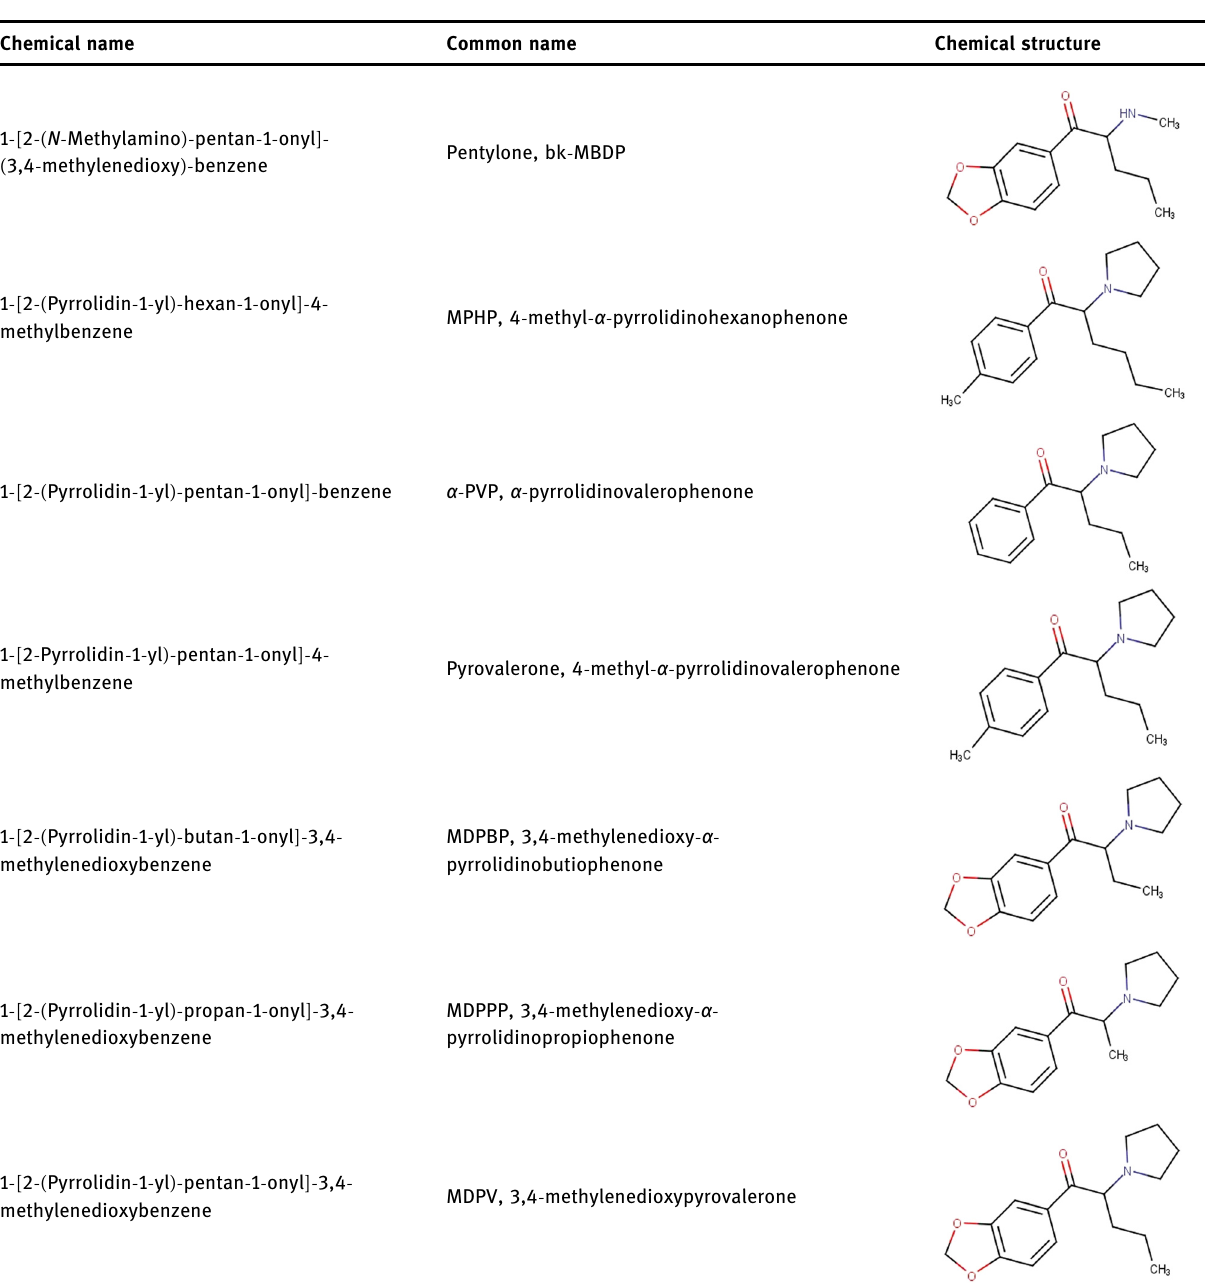
Common name Chemical